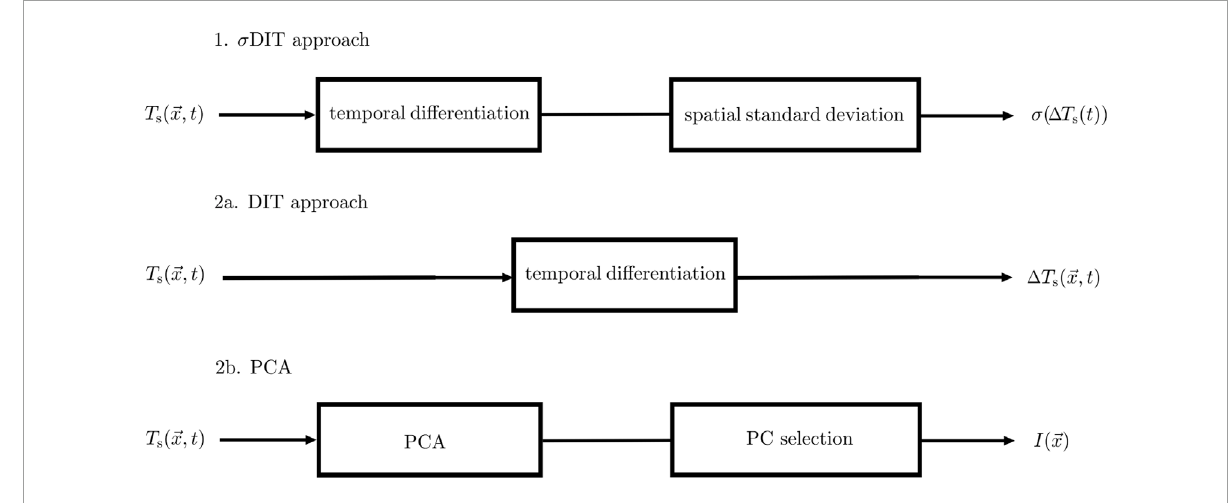
FIGURE 2 Schematic overview of the signal processing